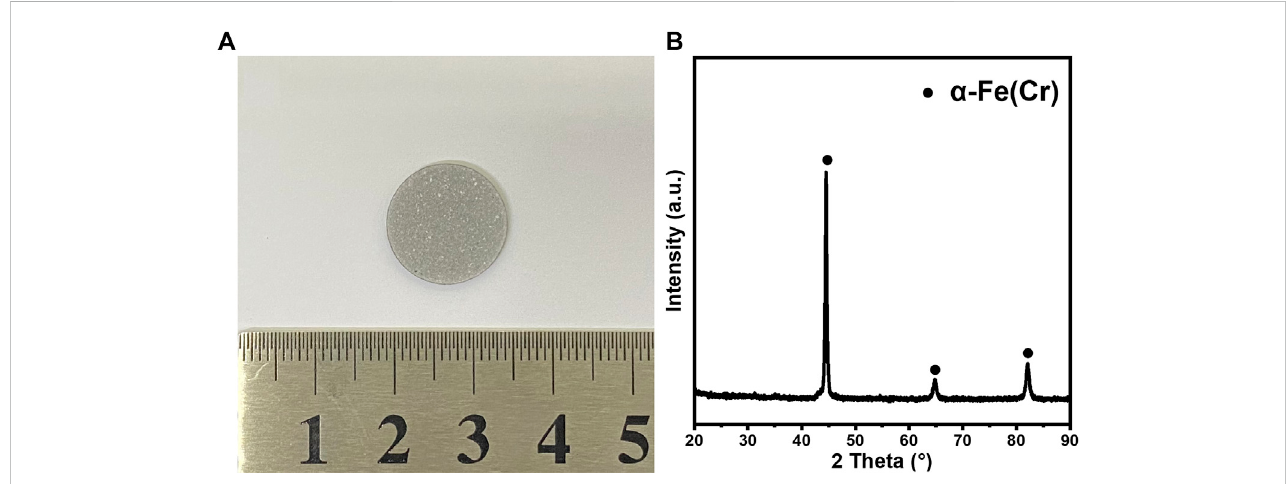
FIGURE 3 SS430L porous support after being sintered at 1350 ° C for 3 h under the puri fi ed 5% H 2 /Ar gas mixture: (A) optical images; (B) XRD pattern. The raw materials contain 24 wt.% starch (based on SS430L).